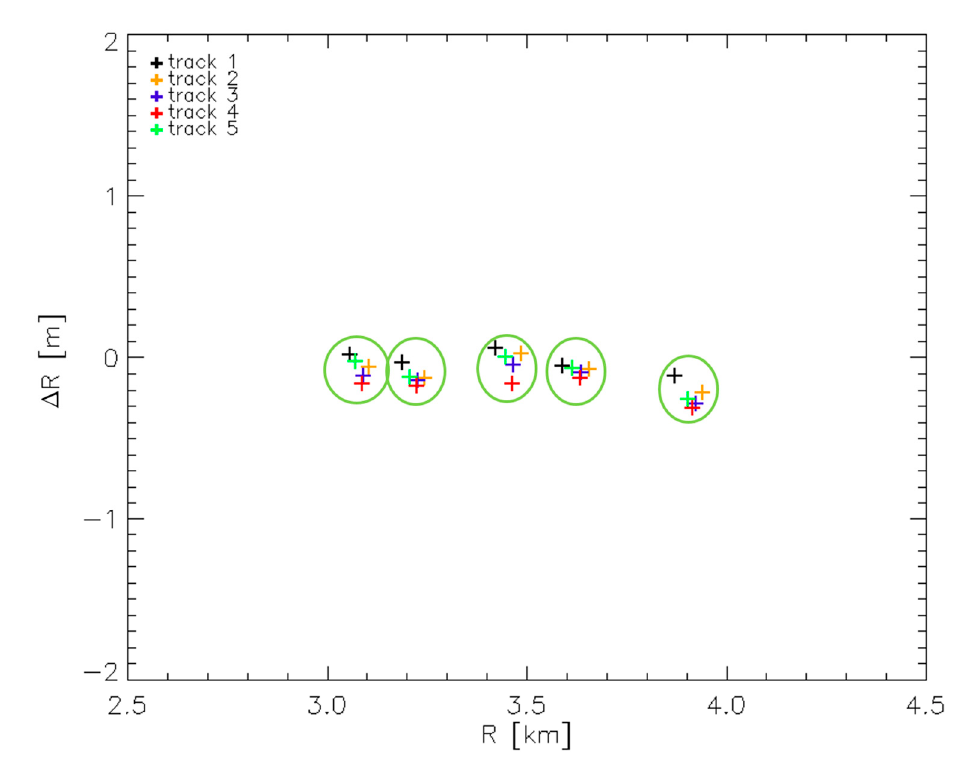
Figure 11. As Figure 10, but using the SAR images focused by using the FSR estimated in the Experiment 6.